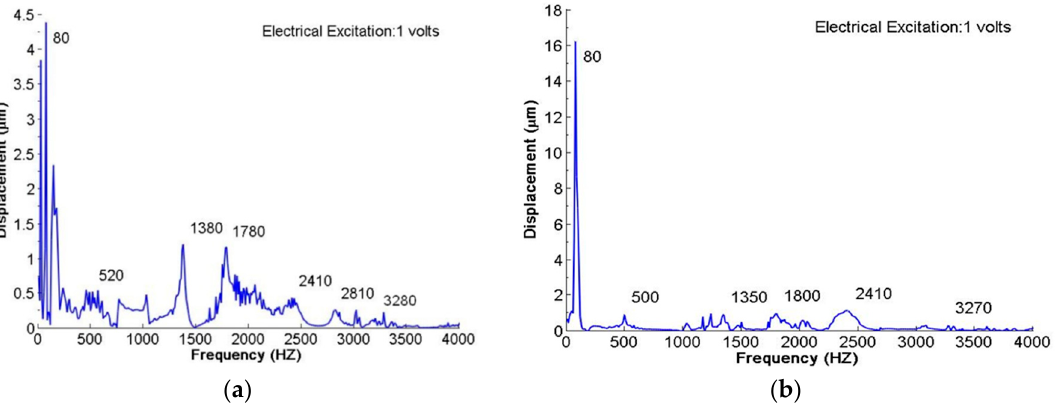
Figure 11. Laser Doppler vibrometer (LDV) displacement spectrum of air-coupled ( a ) anti-phase vibration and ( b ) in-phase vibration.